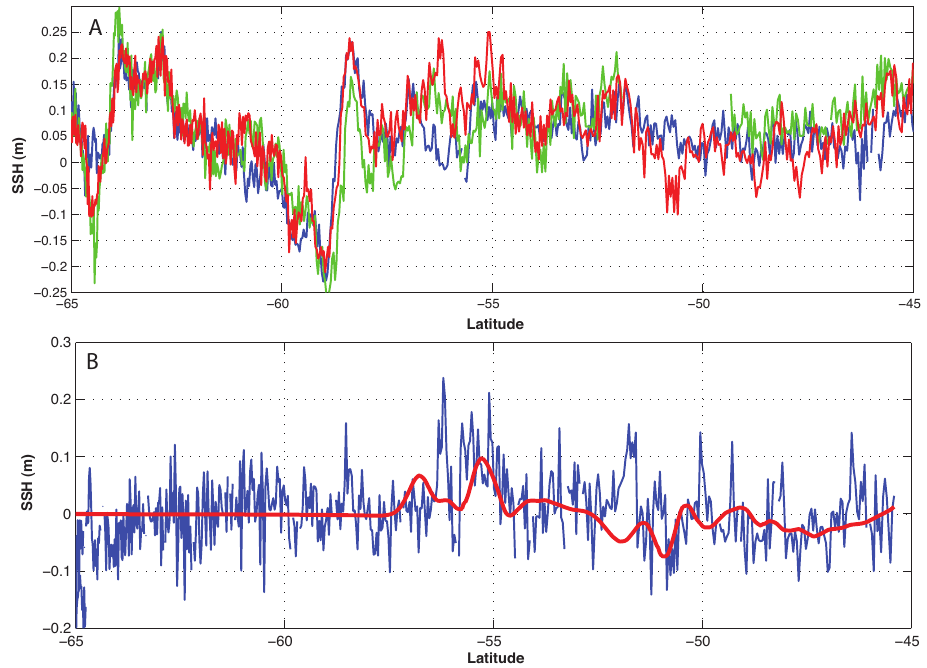
Fig. 2. (A) SSH data for pass 139 of Jason-1 cycles 299 (blue), 300 (red – tsunami) and 301 (green). (B) Filtered SSH data (blue) for pass 139 of cycle 300 with MOST model results (red)